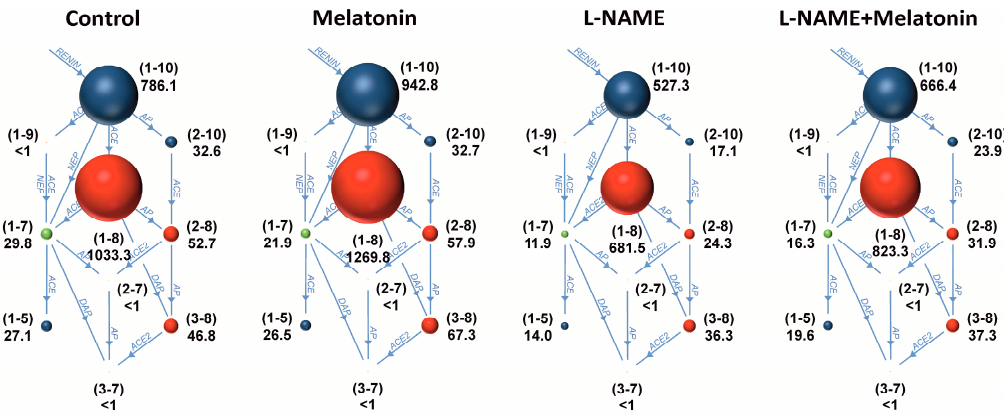
Figure 3. The influence of melatonin ( L -NAME + Melatonin) on the serum level of angiotensins represented as pooling of 10 serum samples per each group. n = 10 per group.